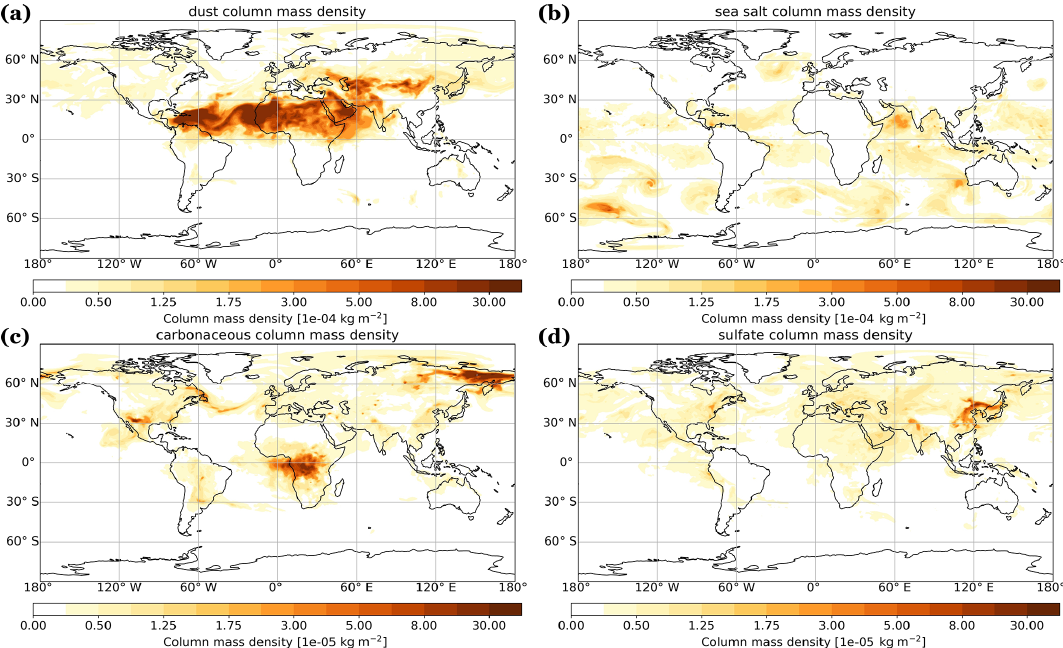
Figure 1. Aerosol column mass density (kgm − 2 ) from MERRA-2 at 12:00Z on 22 June 2020: (a) dust, (b) sea salt, (c) carbonaceous, and (d)